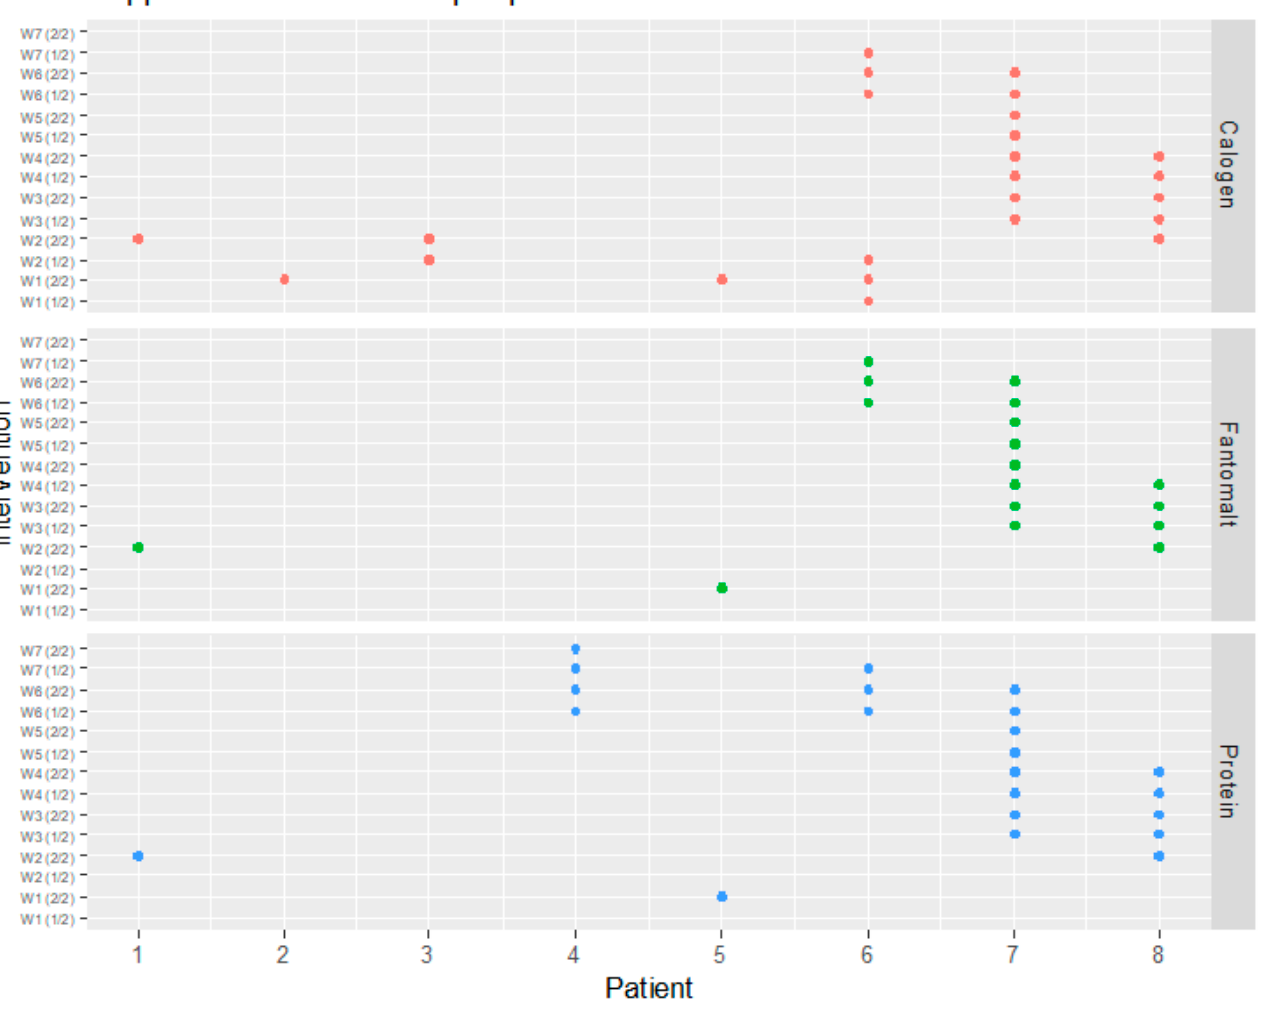
Figure 2. Supplementation per